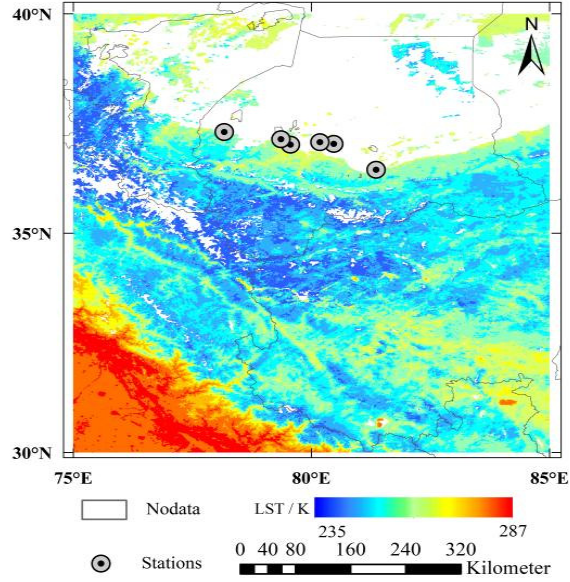
Figure 1. Chart of MODIS LST in the study area as of April 2008.